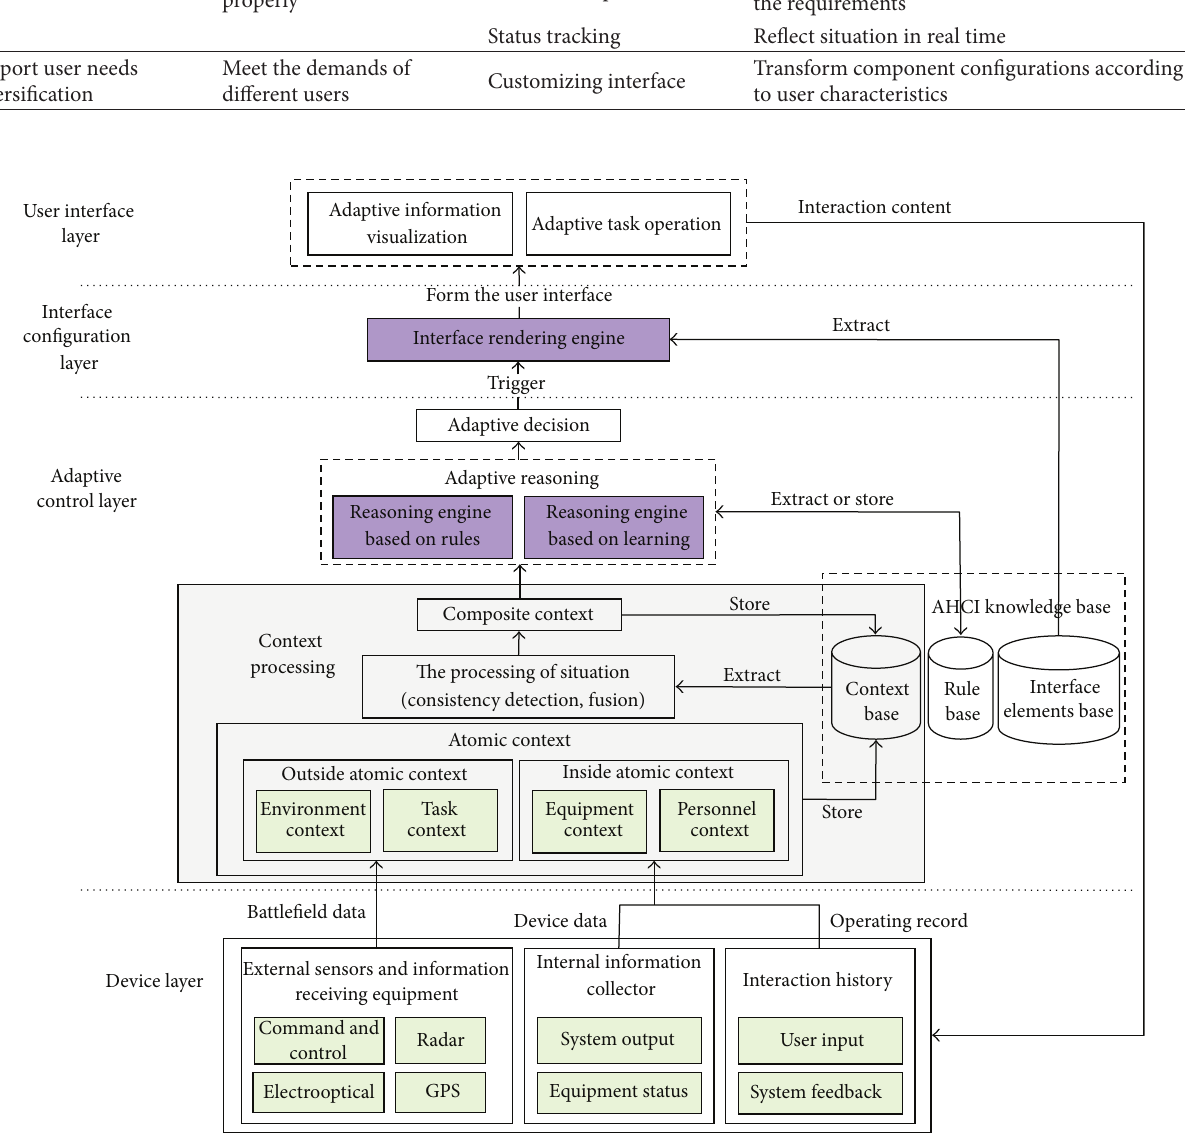
Figure 1: Conceptual architecture for AHCI of the PT operation platform based on